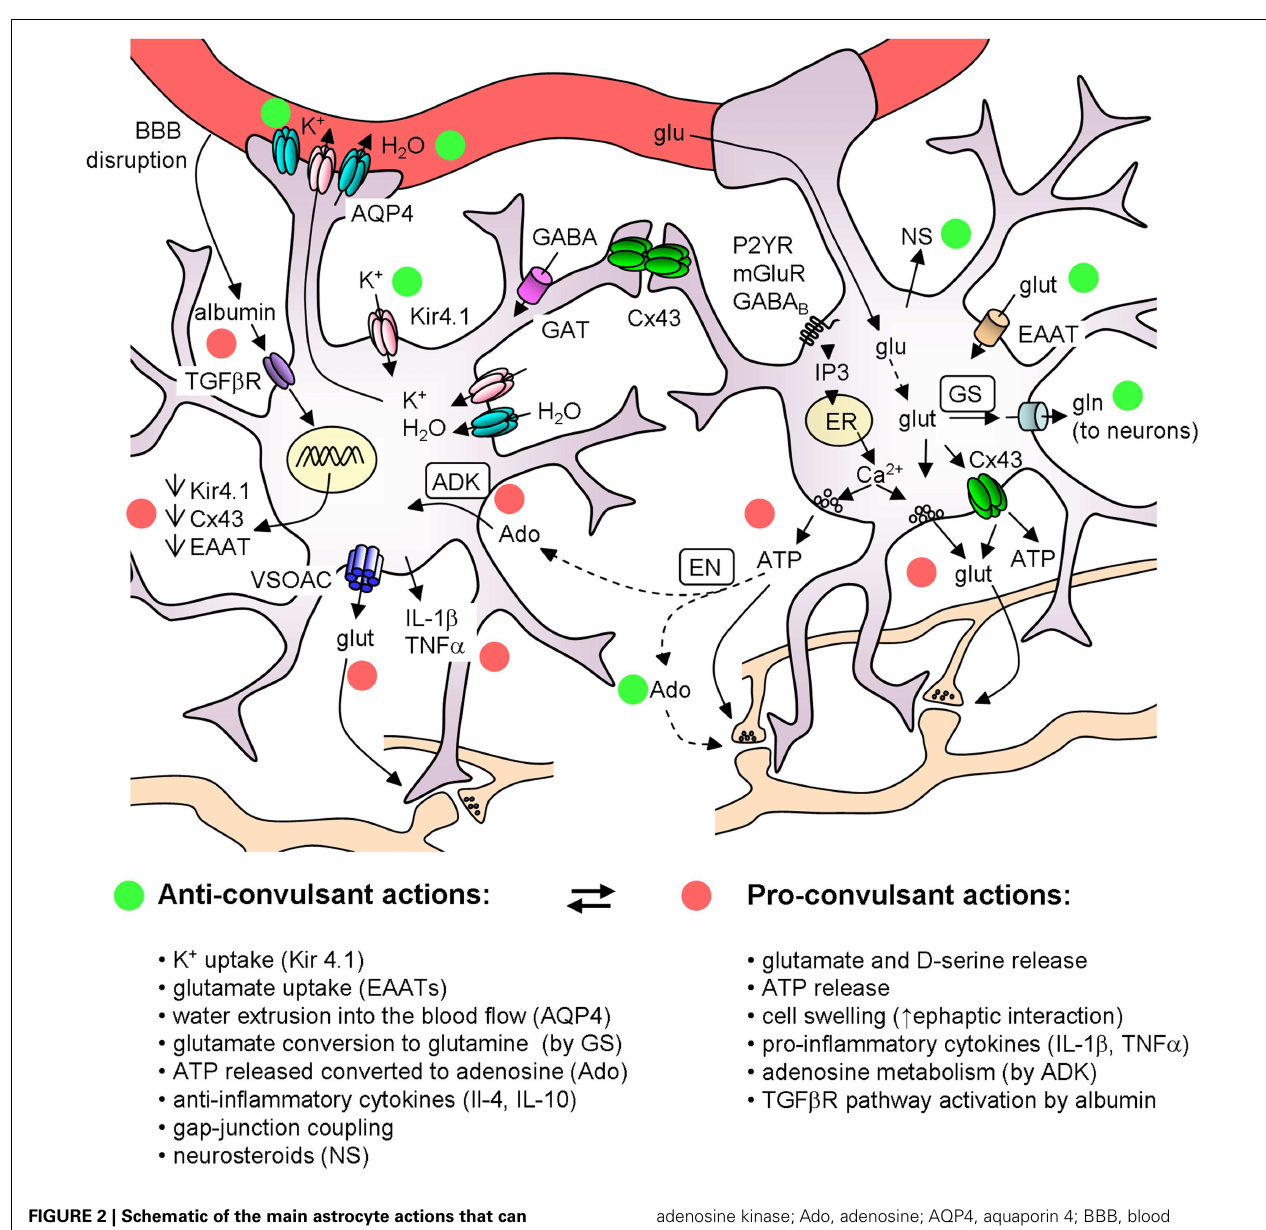
FIGURE 2 | Schematic of the main astrocyte actions that can affect epileptiform activities. The colored circles mark the anticonvulsant (green) and the proconvulsant (red) actions of astrocytes. Note that (i) ATP can have per se a proconvulsant action, but after its conversion to Ado it is anticonvulsant; (ii) astrocytic cytokines can have either pro- or anti-inflammatory actions. ADK,